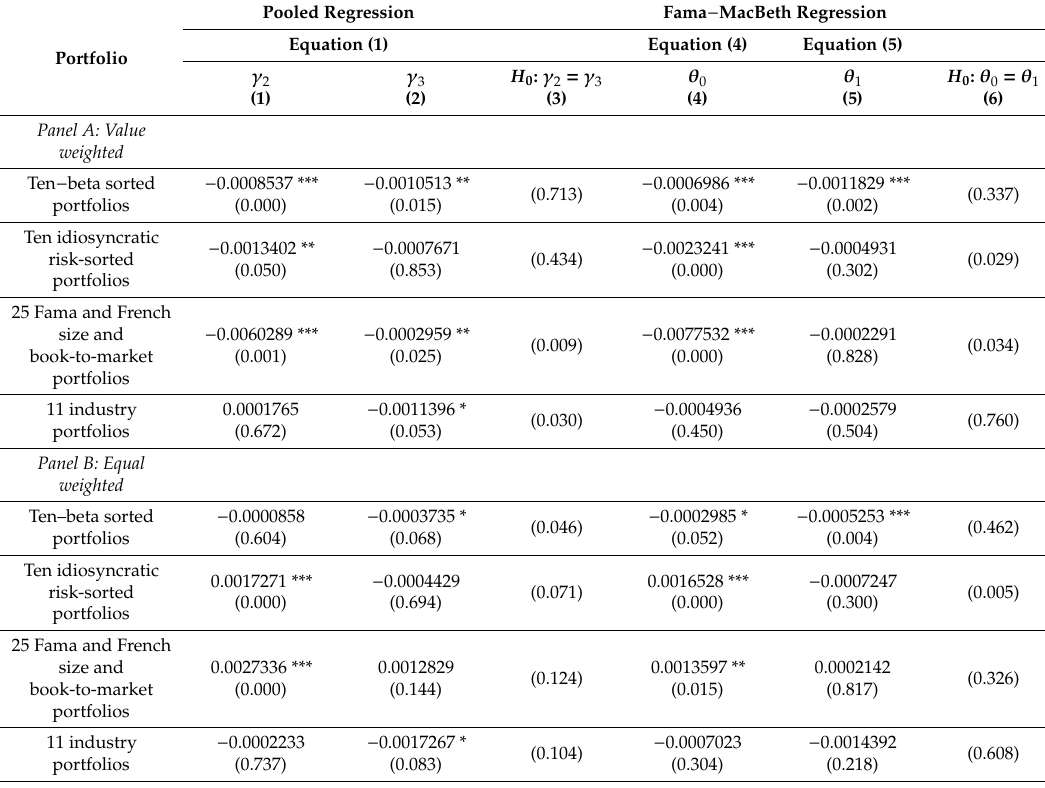
Table 1. Estimation results of Equations (1), (4) and